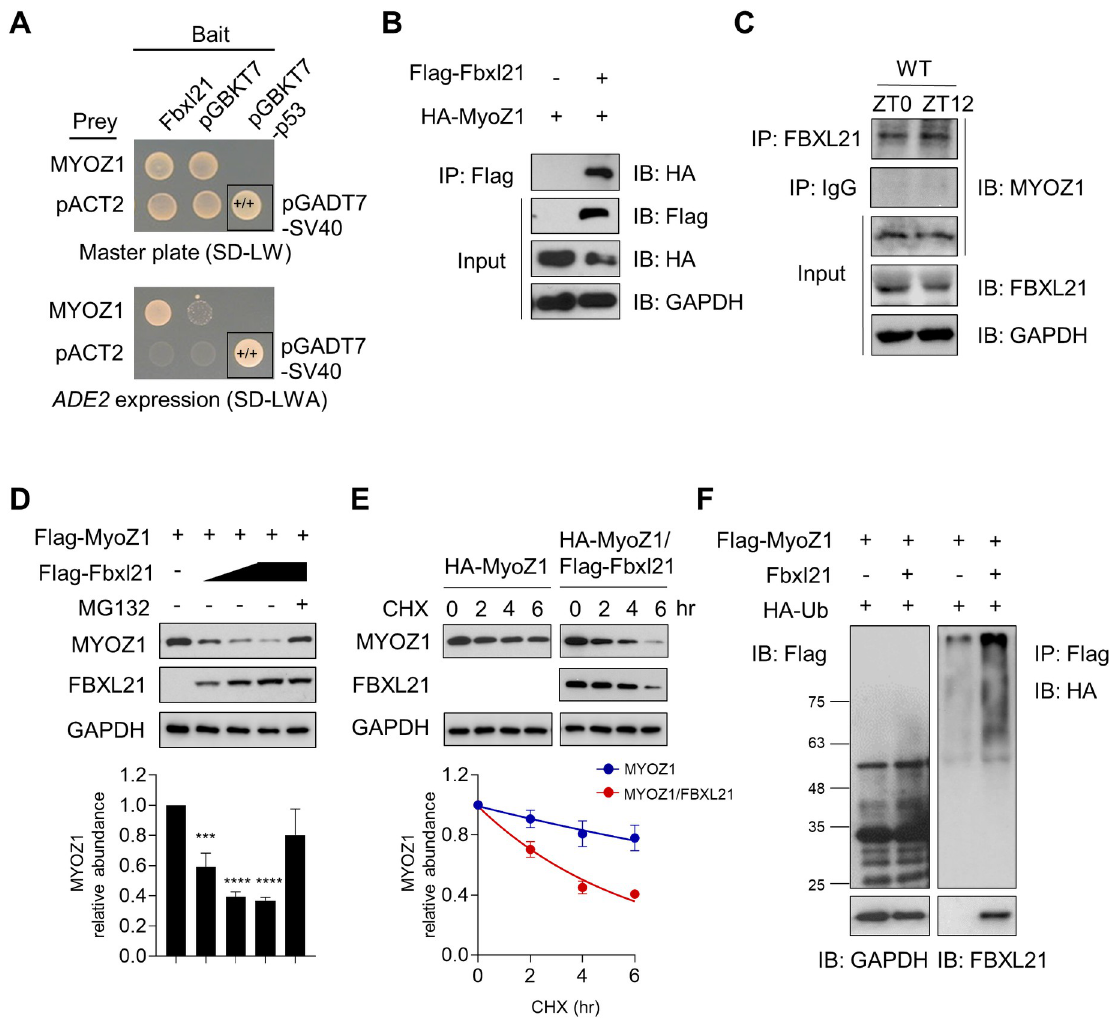
Fig 1. FBXL21 regulates MYOZ1 ubiquitination-mediated degradation. (A) Y2H test showing that FBXL21 interacts with MYOZ1. Positive control yeasts were transformed with pGBKT7-p53 (bait) and pGADT7-SV40 (prey) plasmids encoding the Gal4 DNA-binding domain (BD) fused with murine p53 and the Gal4 activation domain (AD) fused with SV40 large T antigen respectively. (B) Interaction of FBXL21 and MYOZ1. HEK 293T cells were transfected with Flag-Fbxl21 and HA-MyoZ1, and immunoprecipitation was performed using anti-FLAG antibody (M2). (C) Co-immunoprecipitation of MYOZ1/FBXL21 from gastrocnemius tissues of WT C57BL/6J mice at the indicated Zeitgeber time (ZT) using FBXL21 antibody. (D) FBXL21 expression decreased MYOZ1 amount in a dose-dependent manner. 293T cells were co-transfected with Flag-MyoZ1 with increasing amounts of Flag-Fbxl21 as indicated and treated with MG132. The quantification was done using unnormalized optical density (OD) values. Data are presented as mean ± SEM (n = 3). MYOZ1 abundance shows significant statistical differences between MYOZ1 alone and different FBXL21 concentrations. ��� p < 0.001 and ���� p < 0.0001; t- test. (E) MYOZ1 turnover was accelerated in the presence of FBXL21. 293T cells were co-transfected with the indicated plasmids before treatment with 100 μ g/mL CHX. Immunoblotting was conducted to determine MYOZ1 and FBXL21 using anti-HA and anti-Flag antibodies. Lower panel: quantification of the effect of FBXL21 on MYOZ1 stability. Data are presented as mean ± SEM (n = 3). Half-life was calculated by using nonlinear, one-phase decay analysis by GraphPad Prism (MYOZ1, 15.8 hrs, MYOZ1/FBXL21, 4.1 hrs; the half-life parameter, K, is significantly different in Fbxl21 co-expression: ���� p < 0.0001). (F) MYOZ1 ubiquitination mediated by FBXL21. Flag- MyoZ1 was co-transfected with plasmids expressing HA-tagged ubiquitin (HA-Ub), and Fbxl21 (no tag). The protein size markers are shown.